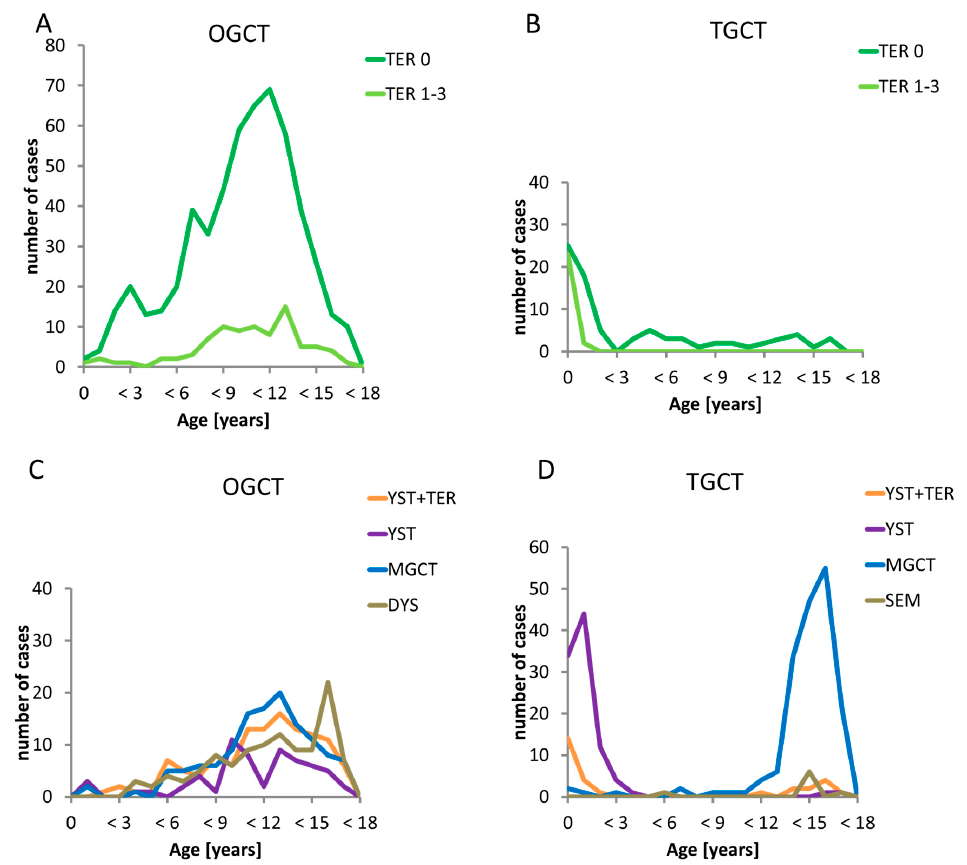
Figure 2. Occurrence of gonadal histology subentities with respect to sex and age. The green lines represent the benign teratomas (TER) according the grade of Gonzales-Crussi divided into grade 1 to 3 (light green) teratoma and teratoma grade 0 (dark green line). The other coloured lines represent the several malignant histological subentities: the yellow line are yolk sac tumor within teratoma components (YST + TER), the violet line represent pure yolk sac tumor, the blue line mixed malignant germ cell tumors (MGCT) and the green line pure dysgerminoma (DYS) / seminoma (SEM). ( A ) Timely occurrence of the benign subentities in ovarian germ cell tumors (OGCT). The occurrence of both benign subentites in the age groups are similar but teratomas grade 0 are occurring more often; ( B ) Timely occurrence of the benign subentities in testicular germ cell tumors (TGCT) The first peak of both teratoma grade 0 and teratomas grade 1-3 appears from birth to 3 years, whereas only teratomas grade 1-3 are seen in the other age groups; ( C ) Timely occurrence of the malignant subentities in ovarian germ cell tumors (OGCT) All malignant subentities occurred during infancy and early childhood with predominant YST histology and presented a slower rise starting at 6 years of age with a peak during adolescence for all malignant GCT subentities; ( D ) Timely occurrence of the malignant subentities in testicular germ cell tumors (TGCT). The first peak consisting of YST occurred from birth to 3 years, whereas the second peak exclusively including MTGCT started at 12 years and reached its highest point at 15 to < 18 years. Between the two peaks, there is an almost complete lack of all malignant subentities over a period of 9